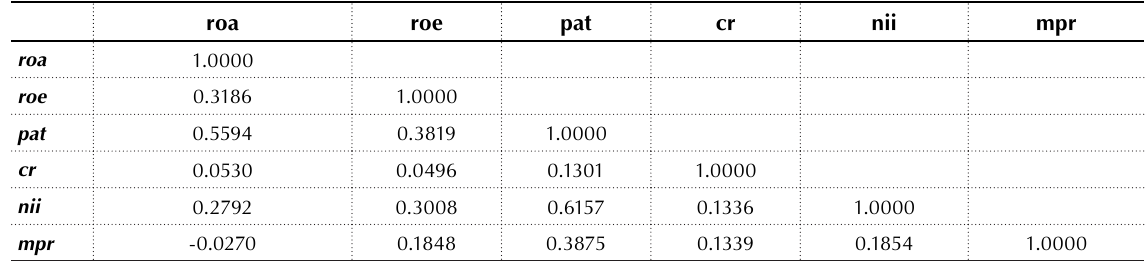
Table 5. Correlation test for